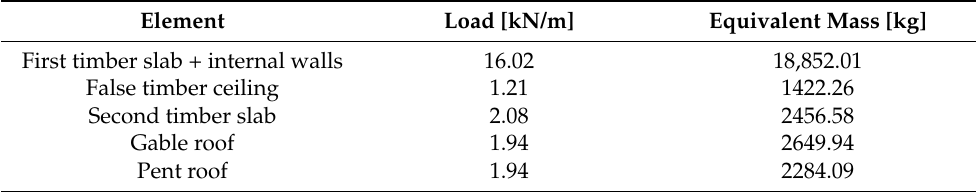
Table 6. Load analyses.